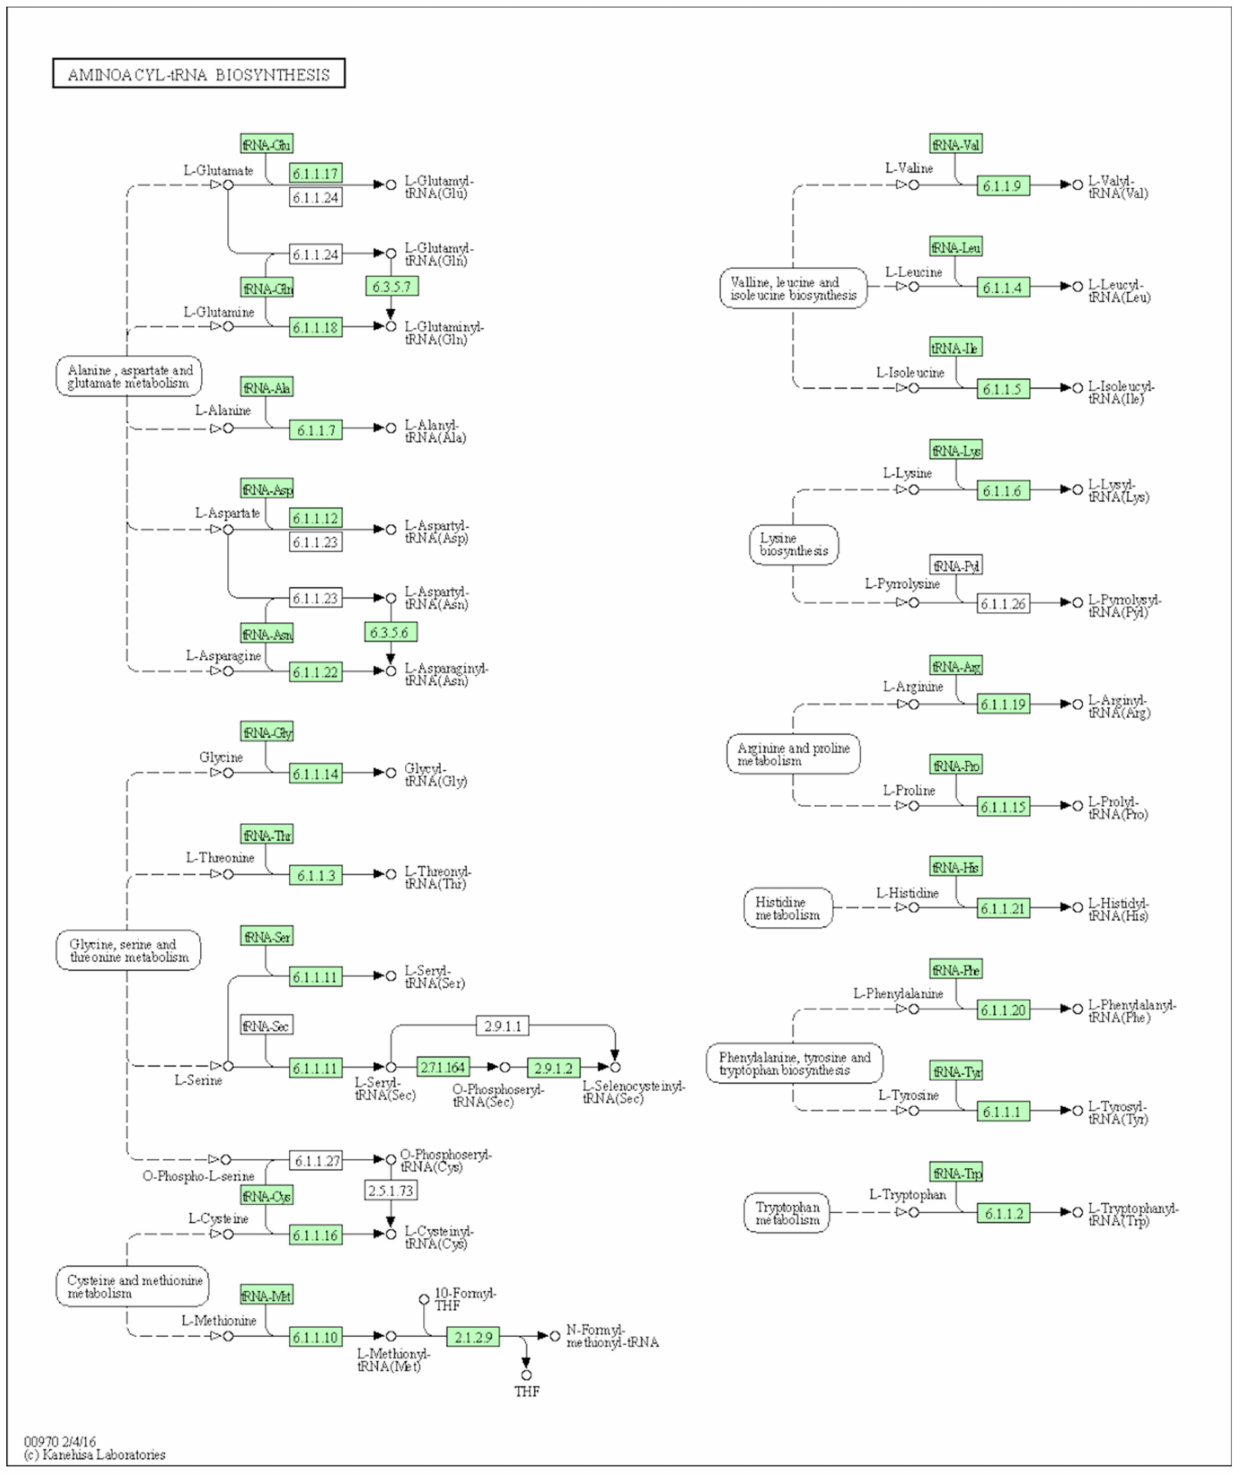
Figure 2. The mechanisms of aminoacyl-tRNA biosynthesis pathway